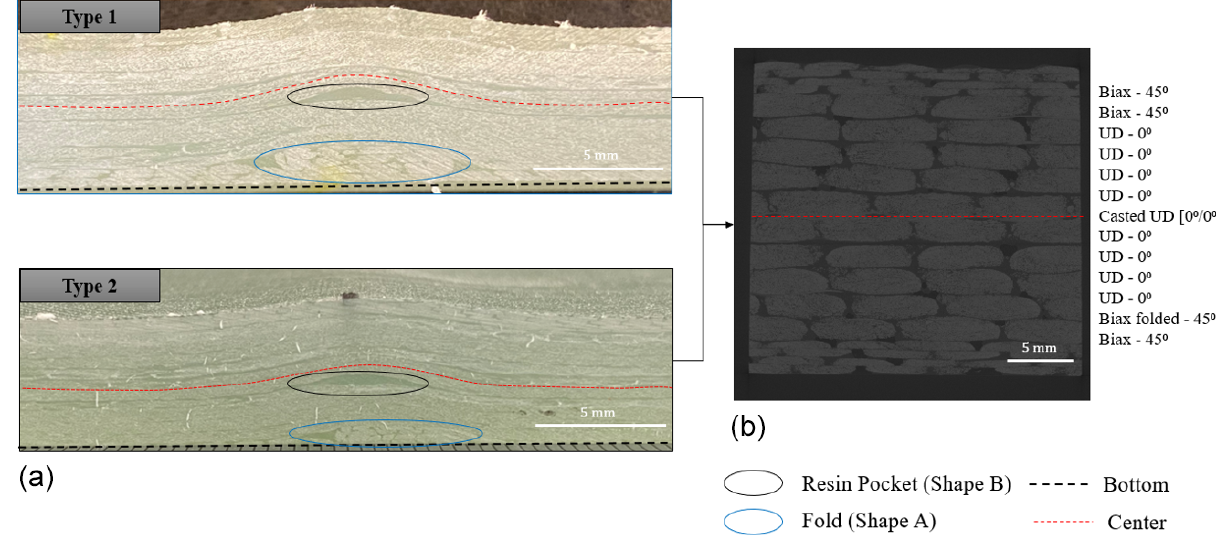
Figure 3. (a) Types of wrinkle configurations selected for the analysis; (b) layup specification for the transverse cross section of the speci- mens taken at the flat region which is similar for both wrinkle types.